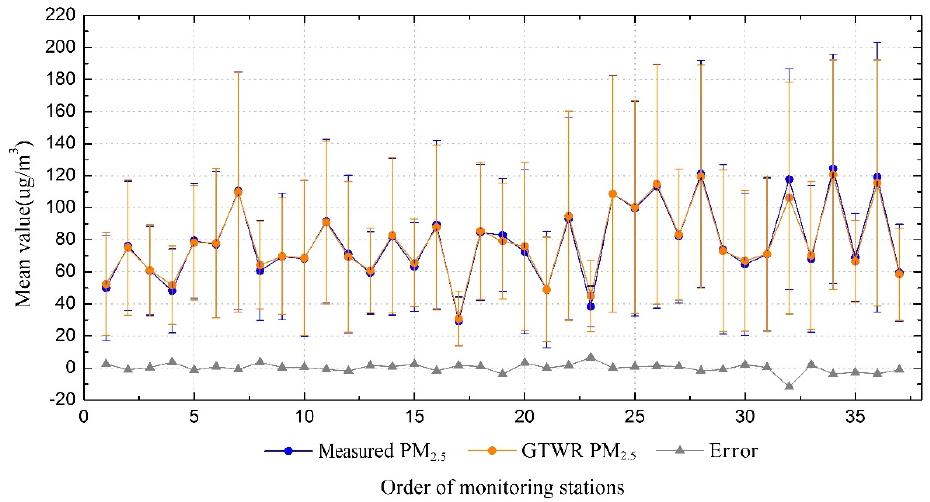
Figure 7. Comparison between GTWR estimations and ground measurements of PM 2.5 concentration.